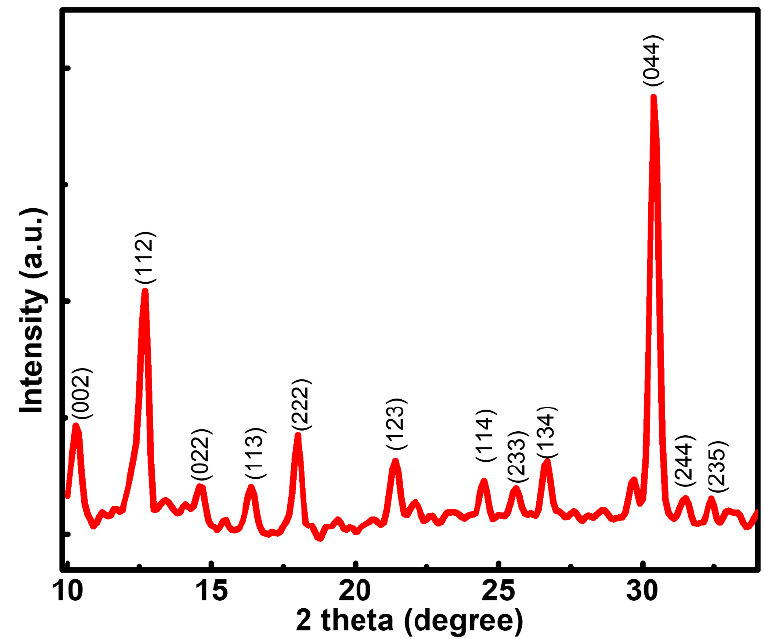
Figure 3. XRD spectra for ZIF-8 nanoparticles.